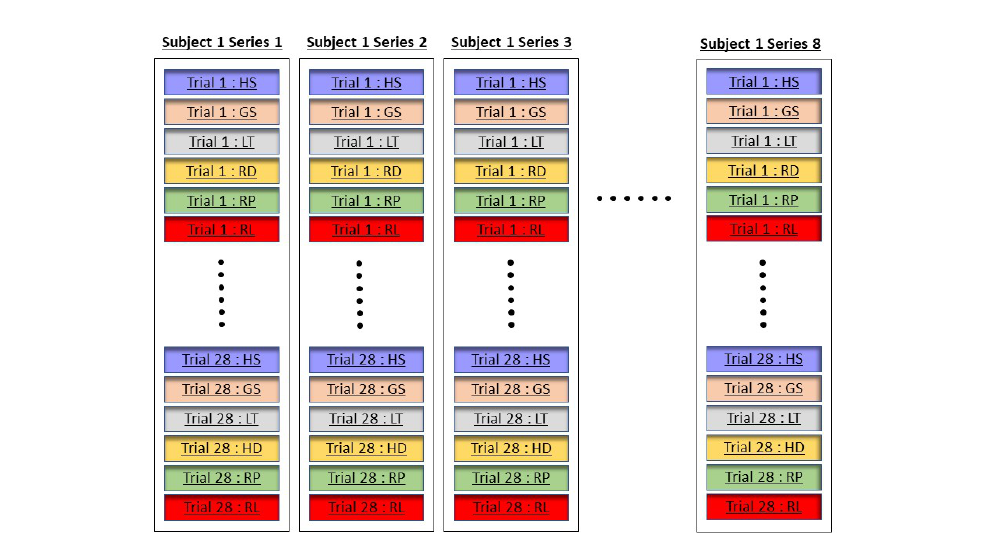
Figure 2. Arrangement of six grasp-and-lift events in EEG data collection for a single subject conducted for eight different